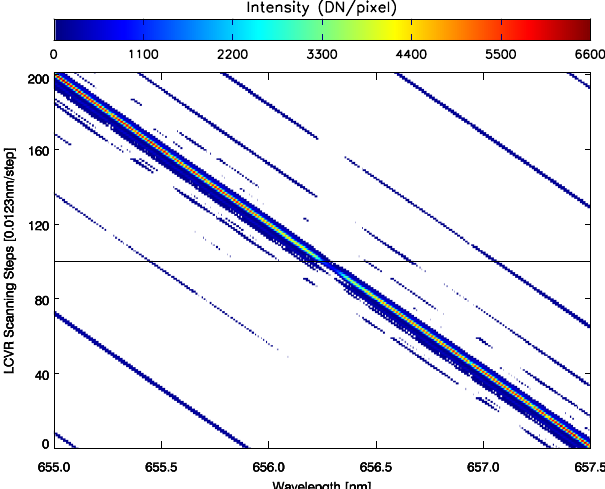
Figure 3. The display of first data set of Fig. 2 for checking these profiles’ symmetry. The trails of main-lobe and other side-lobes on both sides are clear in the coordinates of scanning step and wavelength. The size of side- lobes and their symmetry are the criterion of the BF adjustment.